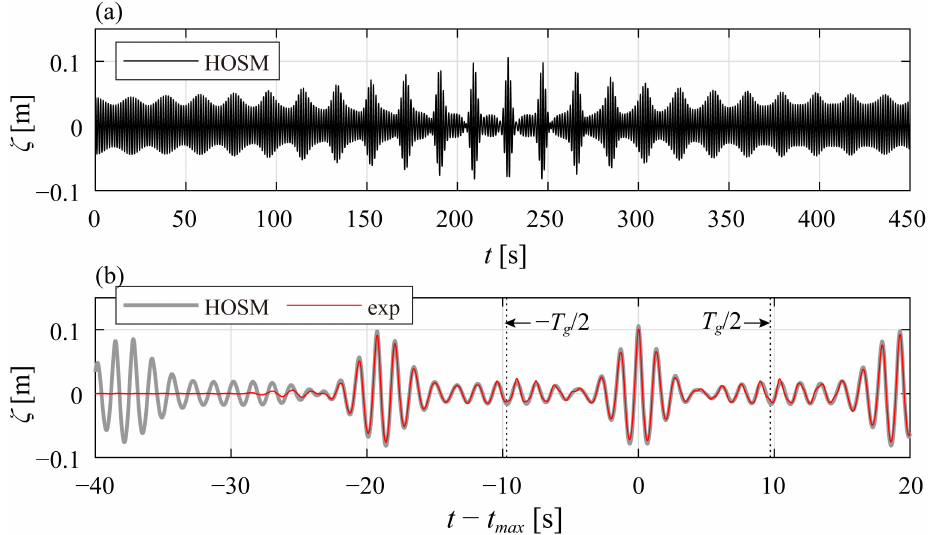
Figure 1. ( a ) Time series of wave elevation of the modulated wave train with a 0 k c = 0.08 simulated with the HOSM. ( b ) Enlarged view of ( a ) around the time of the maximum crest height ( t = t max ), which is compared with the corresponding wave-elevation at x = 12 m measured in the wave